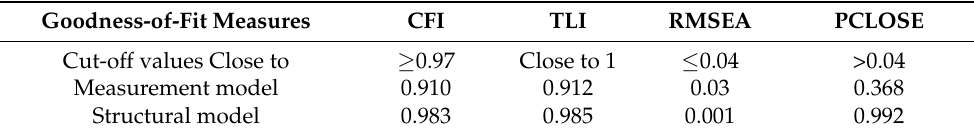
Table 7. Model fit test results.